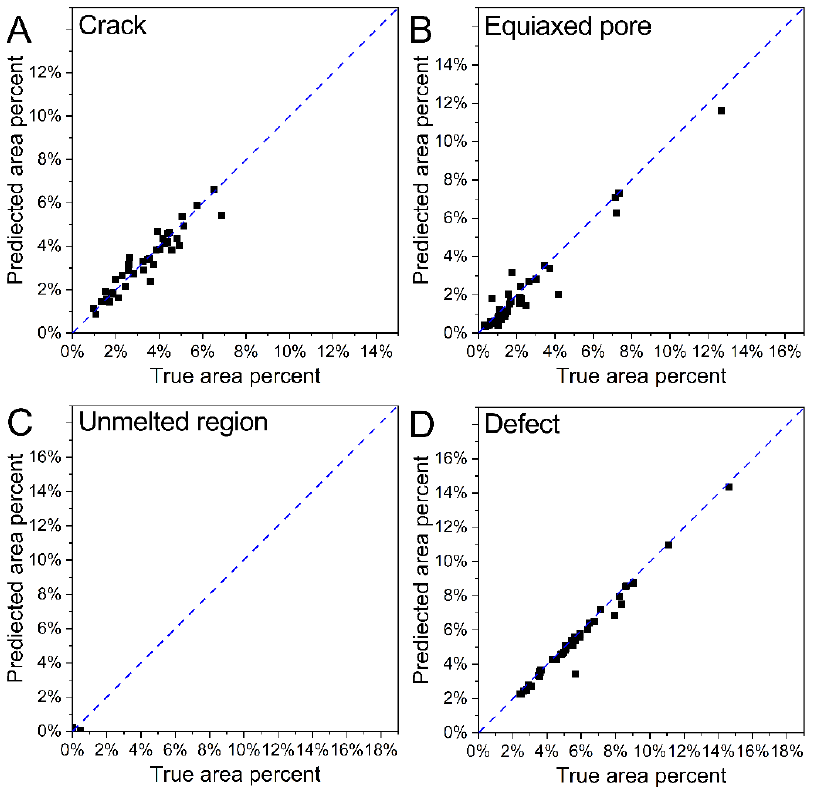
Figure 13. True and predicted area percentages of different objects in the 39 more typical APS TBC images selected from all the 57 test images: ( A ) crack, ( B ) equiaxed pore, ( C ) unmelted region, and ( D ) defect.